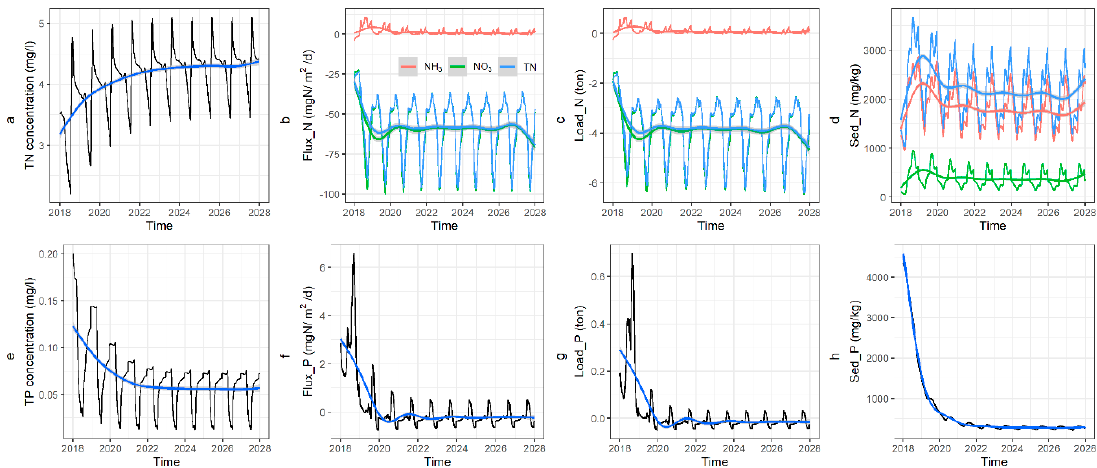
Figure 8. The LAKE2K predicted results. Panels ( a , e ) show the future change tendency of TN and TP in the reservoir; Panels ( b , f ) show the future sediment flux of nitrogen and phosphorus to the overlying water; panels ( c , g ) show the future exchange load of nitrogen and phosphorus across the sediment–water interface; panels ( d , h ) show the future contents of nitrogen and phosphorus in the sediments.